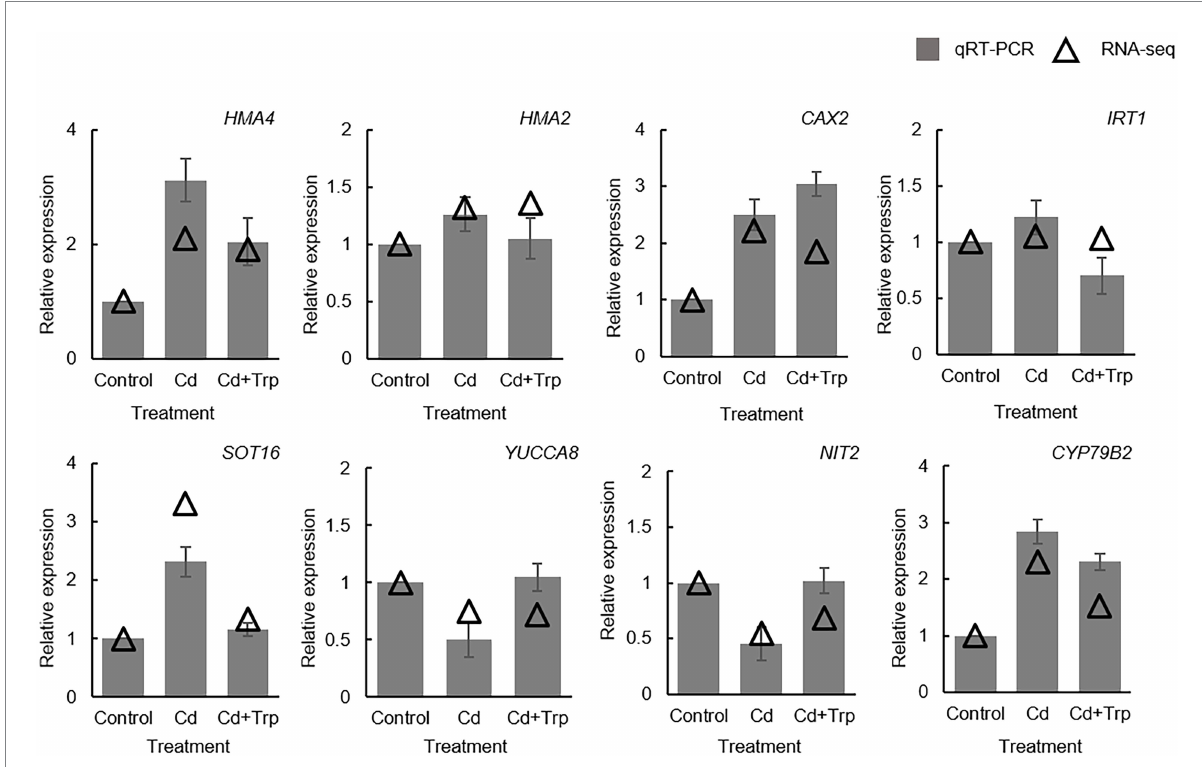
FIGURE 4 Validation of transcriptome data by qRT-PCR. Expression value of the control sample without treatment is set to 1. Relative genes expression levels in comparison with the control are shown. Data were averaged from three independent replicates ±